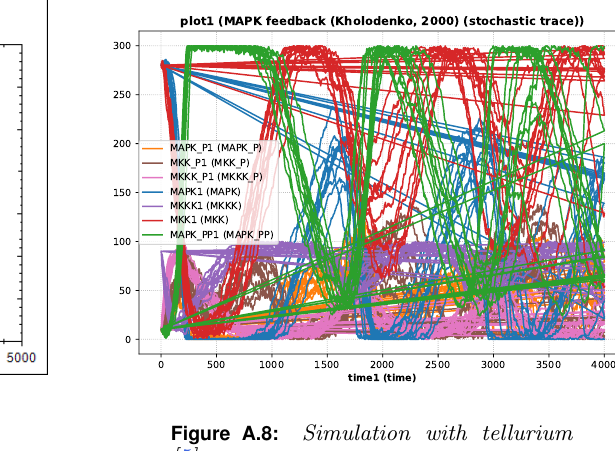
Figure A.8: Simulation with tellurium